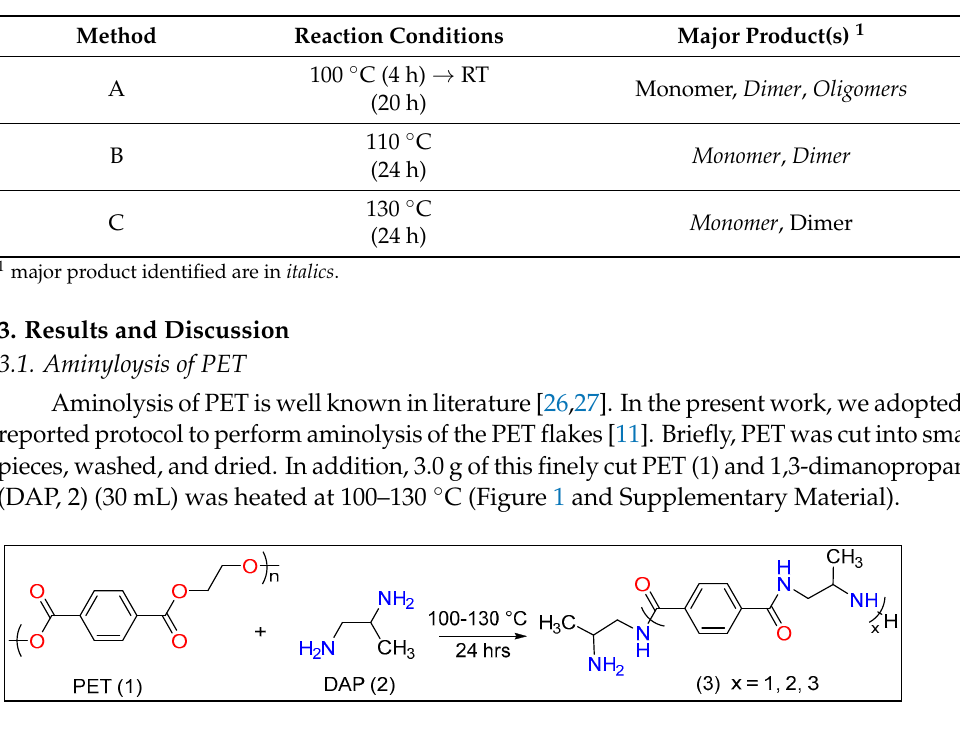
Table 1. Reaction conditions and major products obtained during aminolysis.